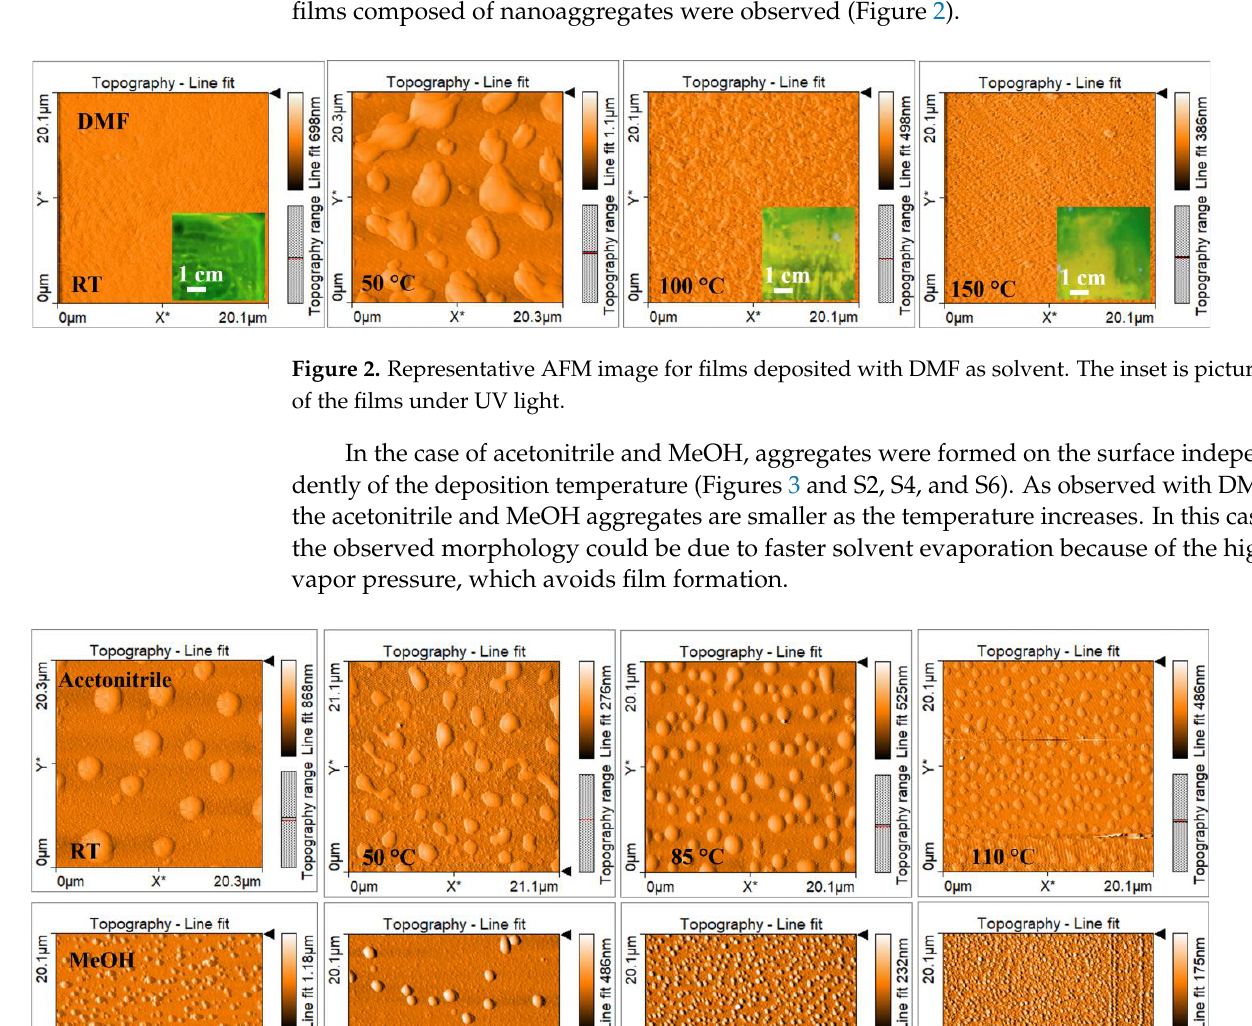
Figure 1. Representative AFM images of compound B films deposited by the blade coating tech-